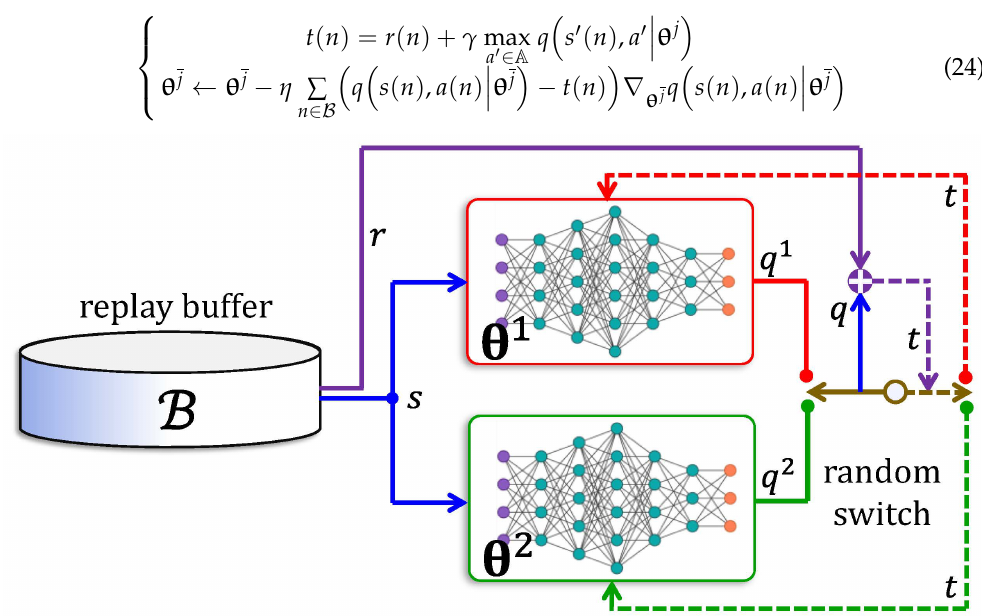
Figure 7. Double DQN. One DQN ( θ 1 or θ 2 ) is picked at random and its Q value ( q 1 or q 2 ) is used to obtain the target ( t ), which is used to train the other DQN. For simplicity only the pathways involved in training are shown. The target pathways are depicted with dotted